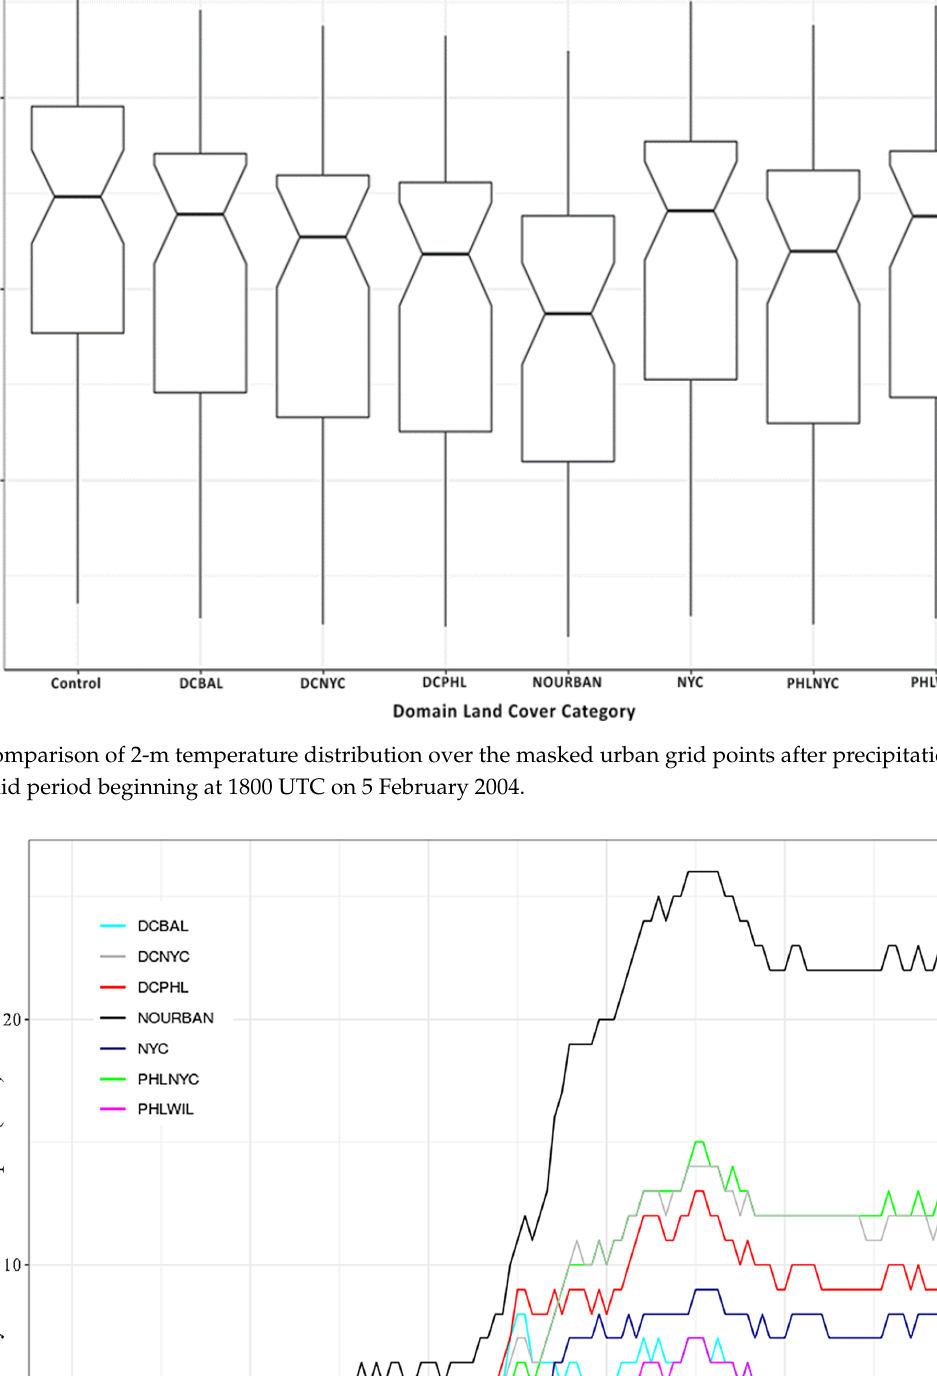
Table 2. Mann–Whitney U test probability values comparing modified datasets to the control da- taset. p -values less than 0.1 (0.05) indicate that the samples are different with greater than 90% (95%) confidence. *Under T 2m , the left column is all times; the right column is during precipitation events after the primary onset at 1800 UTC on 5 February 2004.